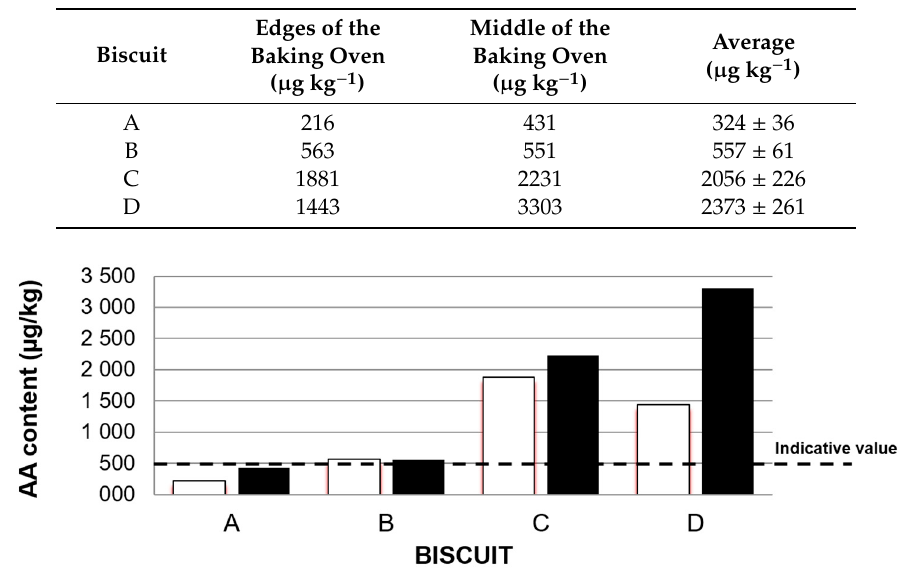
Figure 2. Effect of the position in the oven on the acrylamide content of biscuits. The dashed line depicts the indicative level (500 μ g kg -1 ) reported by the European Food Safe Authority [8]. □ edges of the baking oven ■ middle of the baking oven.